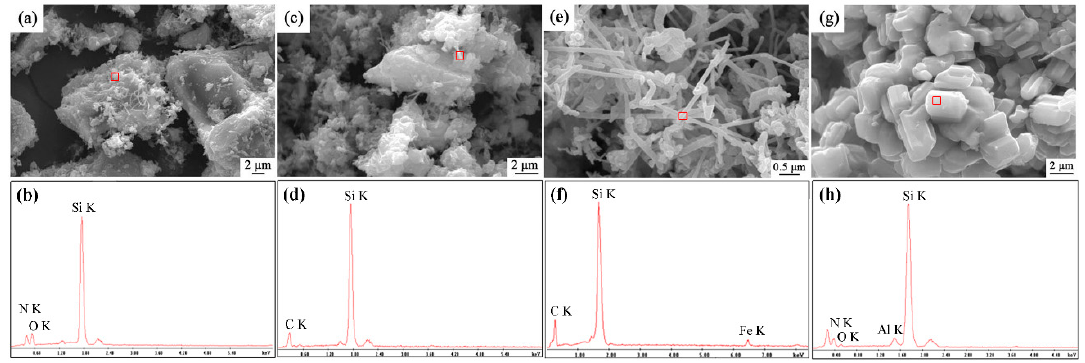
Figure 3. SEM images and X-ray spectroscopies (EDS) patterns of sample S1 nitrided at different temperatures for 3 h: ( a , b )1500 °C, ( c , d ) 1550 °C, ( e , f ) 1570 °C ( g , h ) 1600 °C.